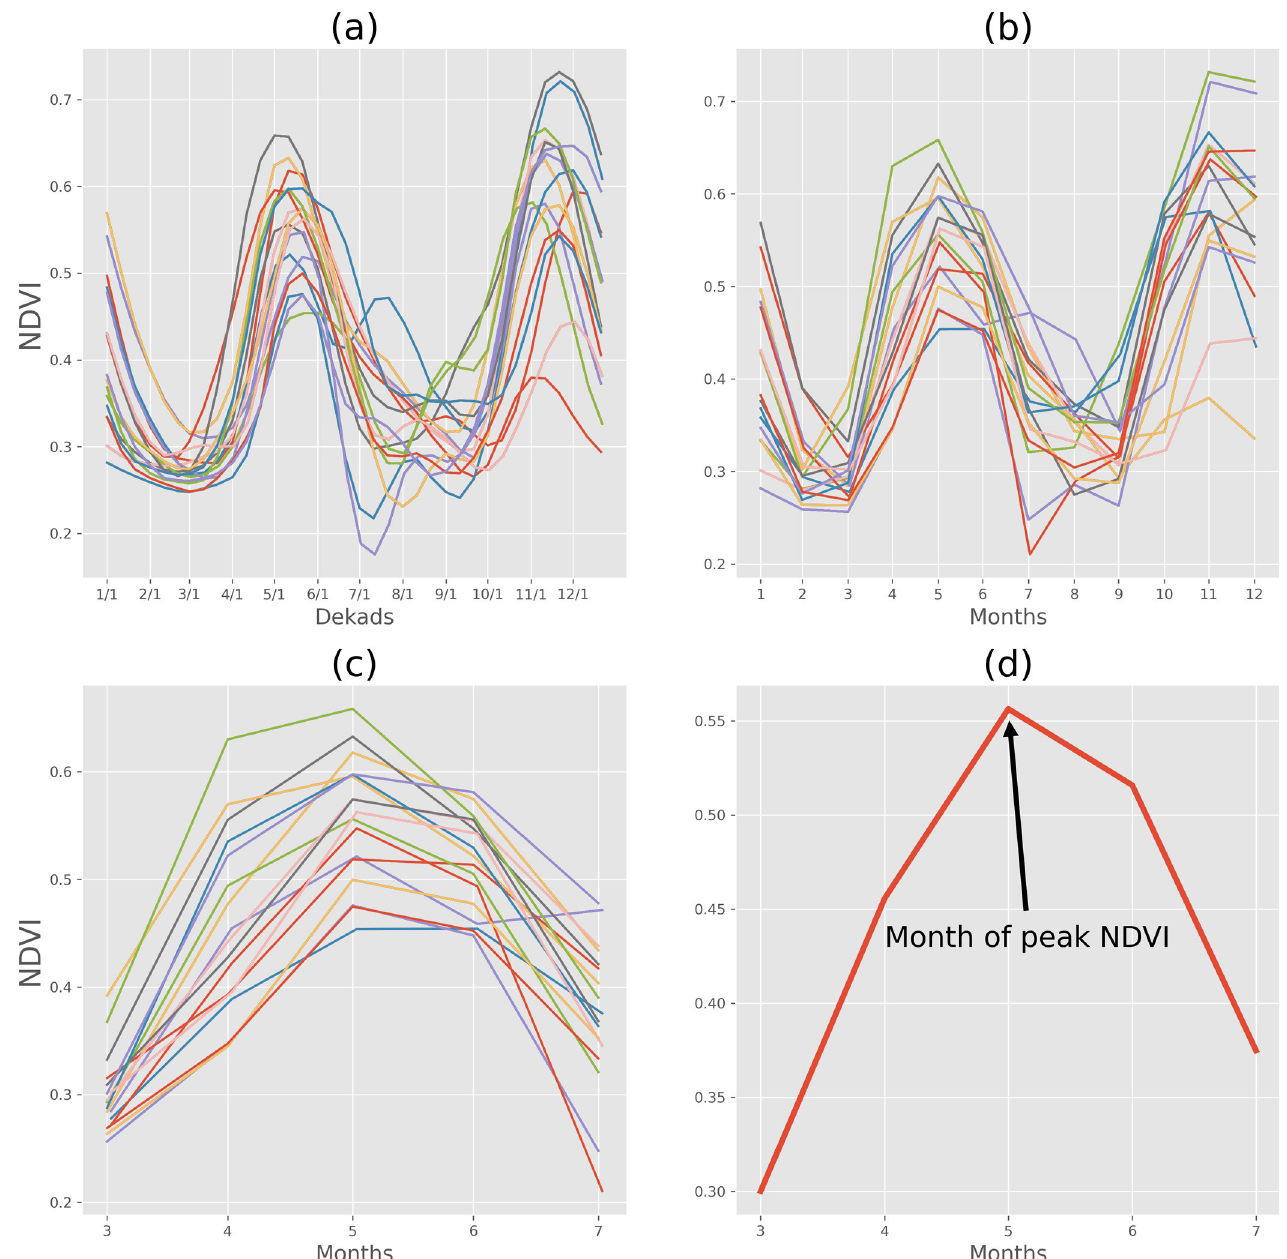
Fig 1. Approach for identifying month with peak NDVI demonstrated using an AU2 in Somalia as an example. (a) Dekdal NDVI between 2003–2018 (b) monthly NDVI (i.e., max dekadal NDVI in a given month) and (c) monthly NDVI for the months within the prescribed 4-month seasonal window from the climatological onset month of March to the end of season month of July (d) climatological mean monthly NDVI for months in (c). Month of peak NDVI is the month that has the highest NDVI during the prescribed seasonal window starting on the climatological onset of the rainy season. https://doi.org/10.1371/journal.pone.0242883.g001 (left panel) shows the climatological onset month (month of onset date) for each of the regions and seasons considered in this study.